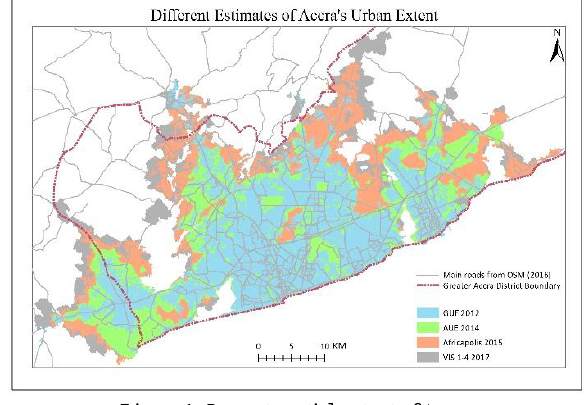
Figure 1. Recent spatial extent of Accra reported by four different